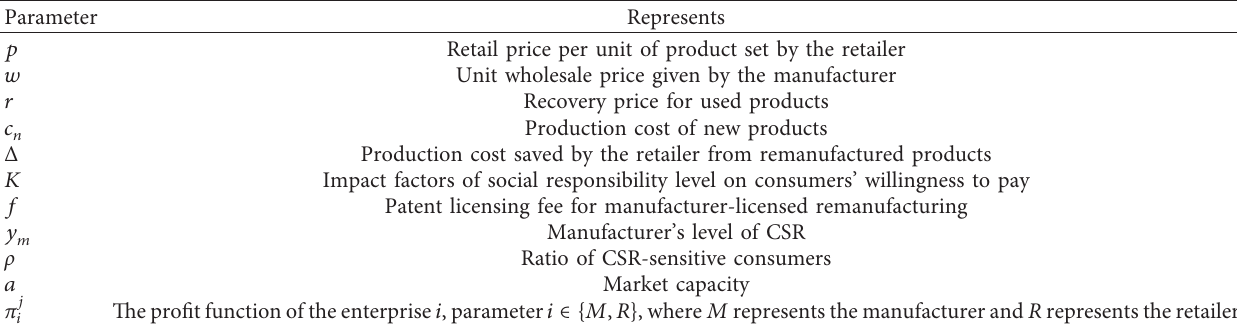
Table 1: Model parameter